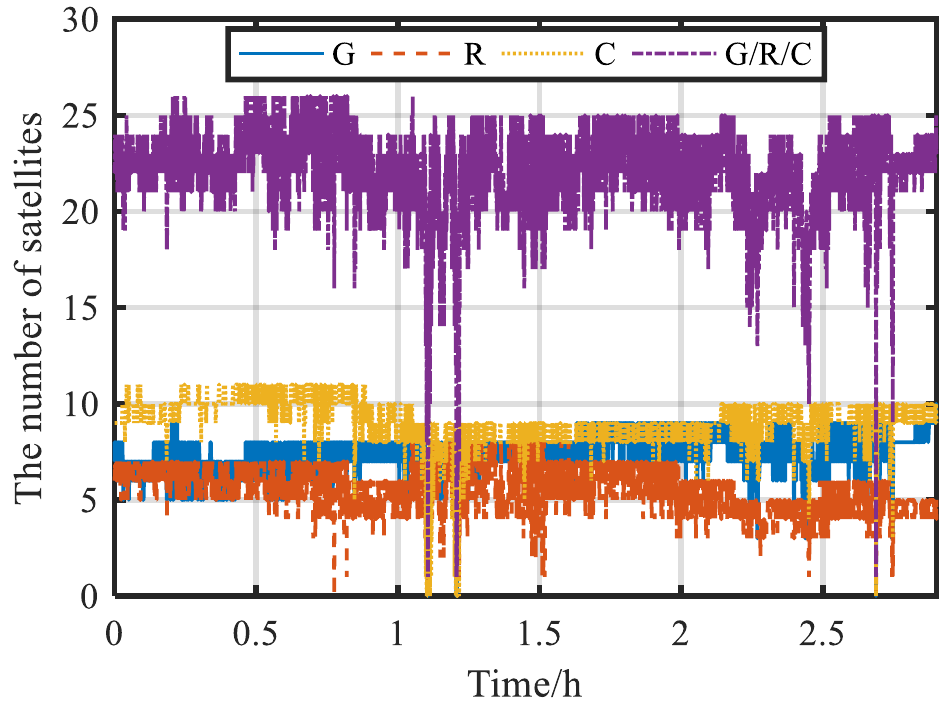
Figure 9. The number of satellites. Table 4. The solution rate of the seven schemes for the dynamic data.